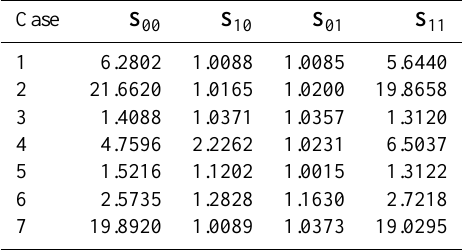
Table C3. Average error for different simplified analysis formula- tions for the overall analysis. The average relative error variance is based on 100000 independent realizations.